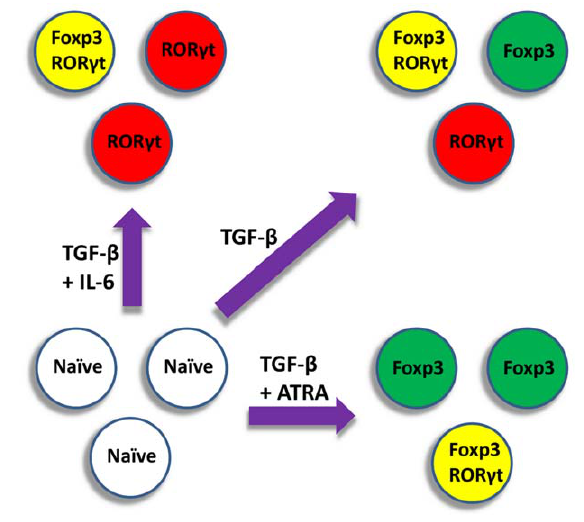
Figure 1. Induction of differentiation from naı ¨ ve CD4 + T cells to T H 17 and iT reg . A population of antigen-activated naı¨ve CD4 + T cells (white) can be induced by different types of cytokine micro- environment to produce corresponding differentiated cell populations. T H 17 cells (red) express the ROR c t transcription factor, and iT reg cells (green) express the Foxp3 transcription factor. Some cells (yellow) express both master regulators and may possess both regulatory and pro-inflammatory functions.